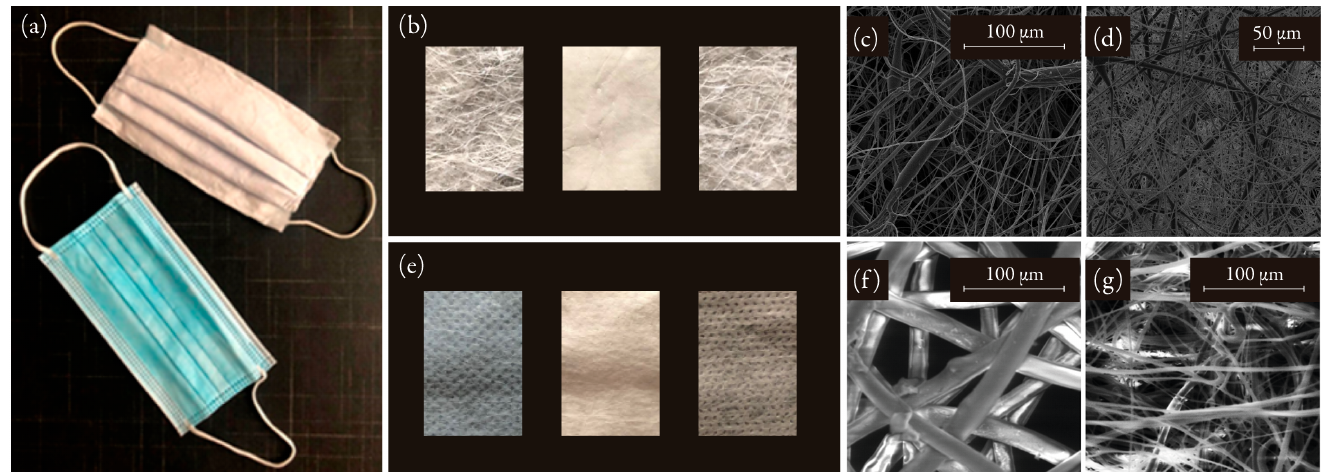
Figure 9. ( a ) PET-based surgical mask developed in this work (top) and a commercial surgical mask (bottom). ( b ) Macroscopic detail of the layers that make up the PET-based mask and ( c ) SEM views of the external layers and ( d ) the filter. ( e ) Macroscopic detail of the layers that make up the commercial surgical mask and ( f ) SEM views of the external layers and ( g ) the filter placed in the middle. Table 4. Parameters used for electrospinning a surgical mask. Parameters Filter External Layers PET concentration 25 wt.% 25 wt.% Voltage ∼(cid:52) 15 kV ∼(cid:52) 25 kV Needle distance 25 cm 15 cm Solution flow rate 9.9 mL/h 9.9